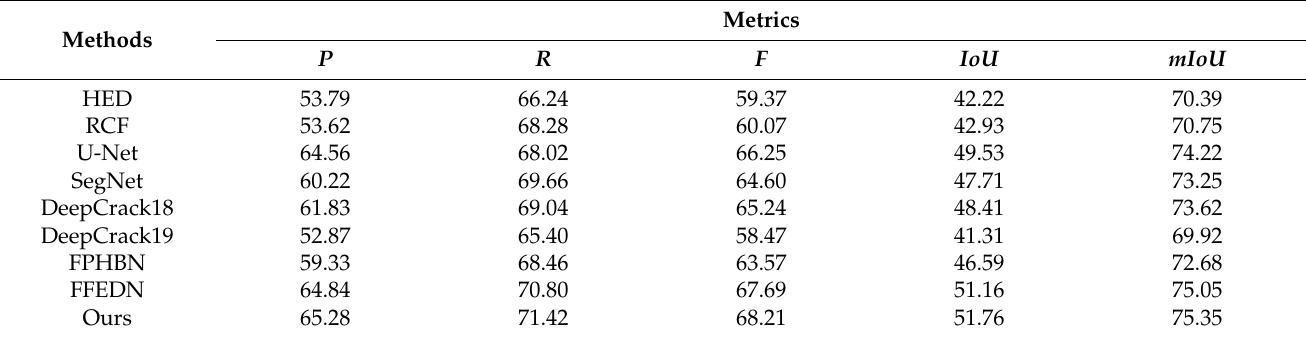
Table 3. Comparison results on AED.